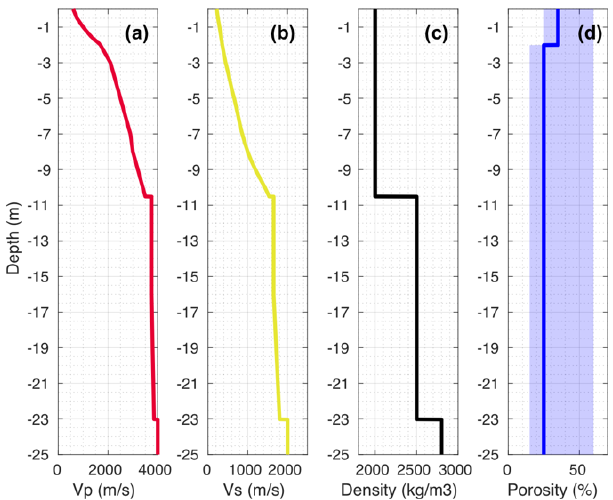
Figure 6. Seismic velocity models of the Gugla rock glacier, based on geophysical investigations (seismic refraction) and from bore- hole data, with P-wave velocity (a) and S-wave velocity (b) profiles. The density (c) and the medium porosity ( d , solid blue line) profiles are also shown, with low and high limits of the porosity used in the subsequent mechanical